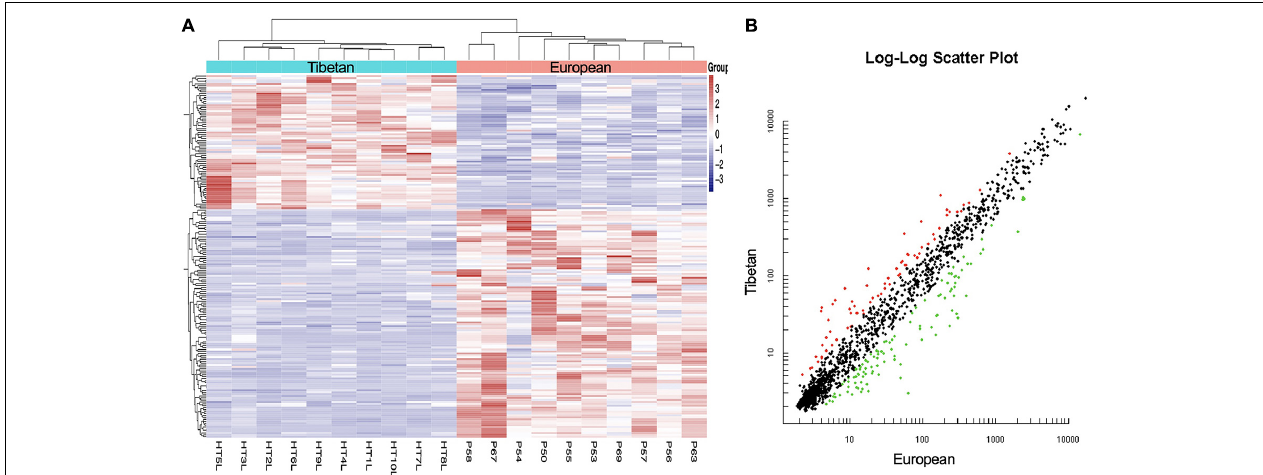
FIGURE 1 | Hierarchical clustering (A) and scatter plot (B) of all included mature miRNAs from Tibetan and European women’s placentas. (A) The Y -axis represents specific miRNAs and the X -axis represents individual samples, with the blue on the top representing Tibetan and the red representing European. The color frame represents the log2 intensities of the miRNAs; purple = low expression and red = high expression. (B) Green dot is the down regulated miRNA and red dot is the up regulated miRNA.